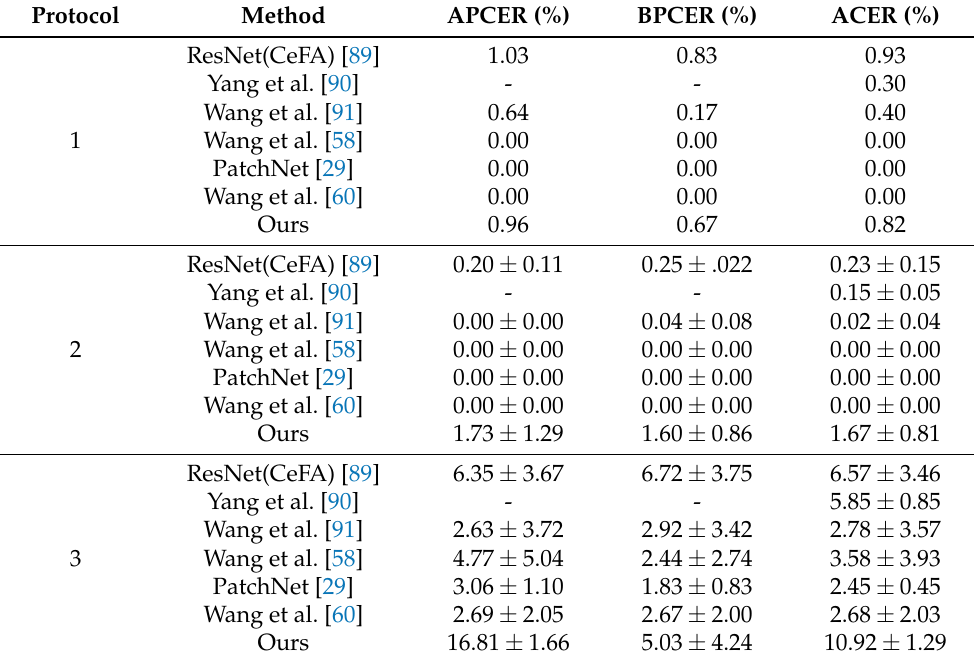
Table 5. Comparison on SiW protocols for face anti-spoofing task. Protocol 1 tests anti-spoofing with unseen poses, protocol 2 tests it with varying replay mediums, and protocol 3 tests on unseen attack types (print vs. video). Our facial geometry representation is sensitive enough to transfer to fine tasks such as